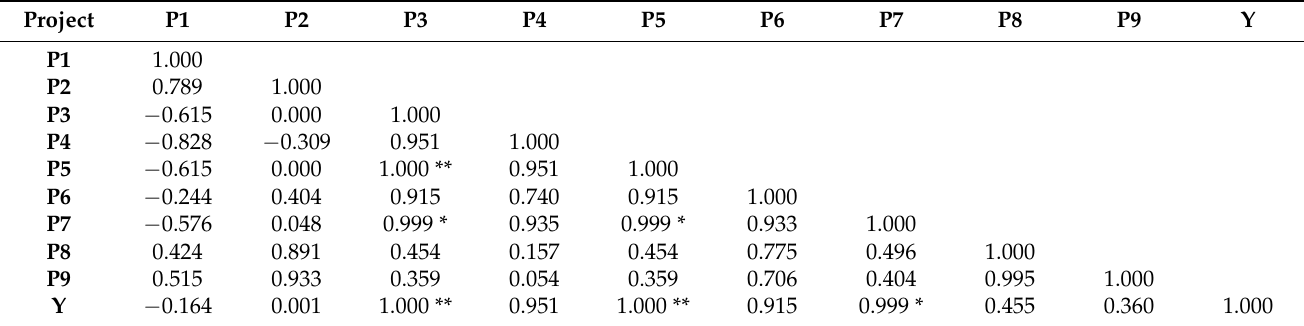
Table 3. Correlation coefficients between soil properties and crop yields.